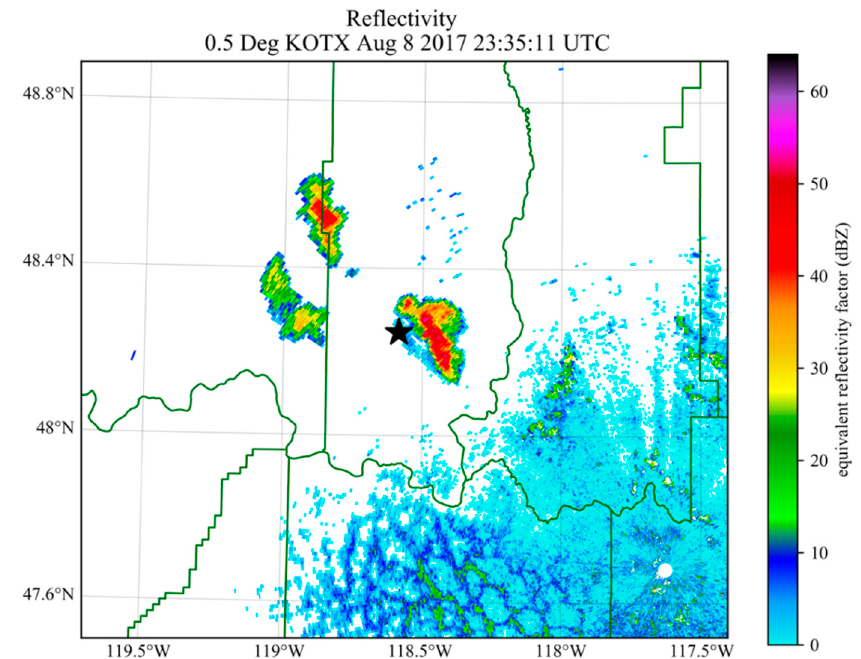
Figure 11. Base reflectivity (dBZ) from the WSR-88D radar in Spokane, Washington [45]. The black star denotes the location where the Bridge Creek Fire started. The time shown is near the time of the FS stroke’s discharge.